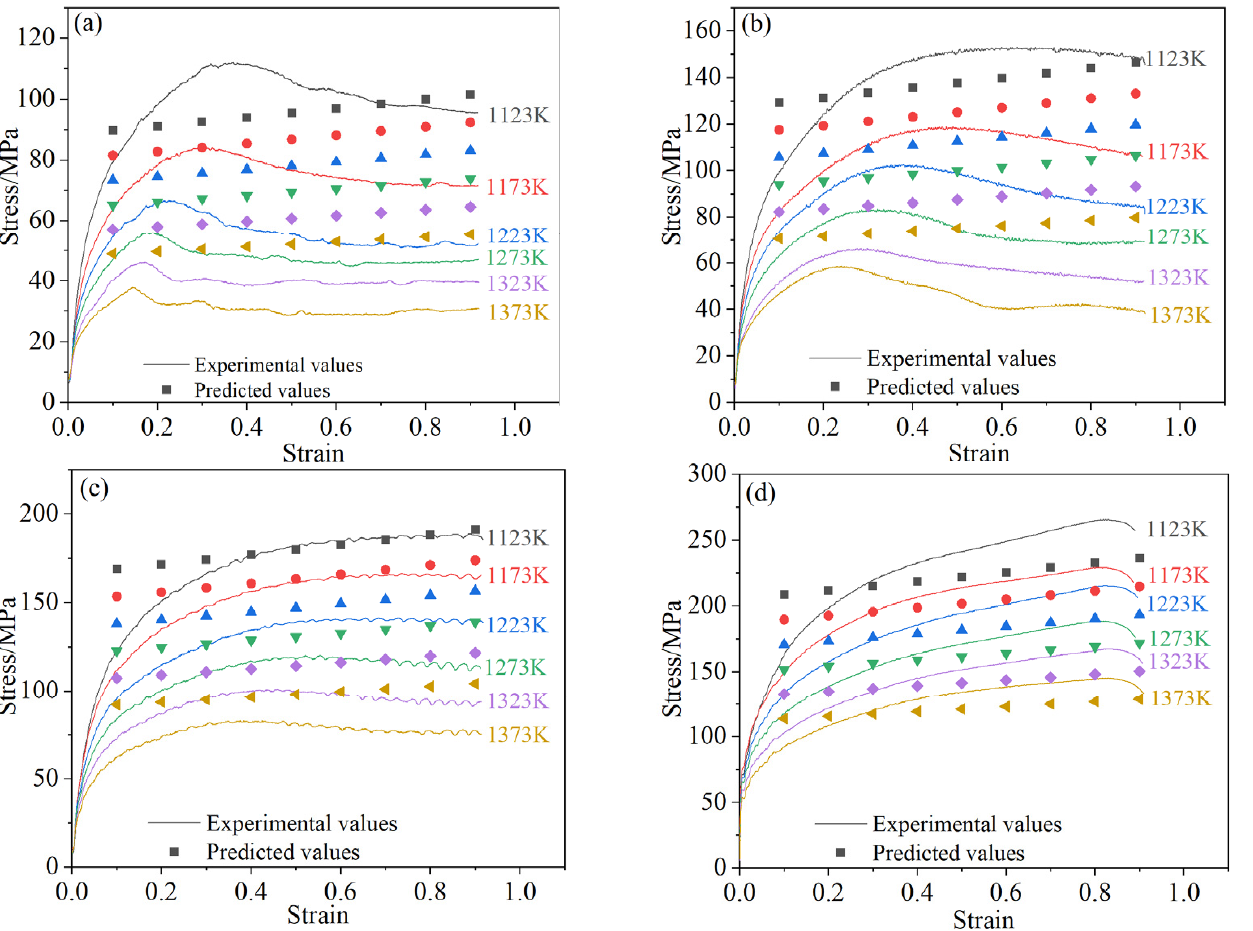
Figure 4. Comparison between predicted and experimental flow stress using Johnson–Cook model at different strain rates: ( a ) 0.01 s − 1 ; ( b ) 0.1 s − 1 ; ( c ) 1 s − 1 ; ( d ) 10 s − 1 . Table 3. Absolute error mean value and relative error mean value of three kinds of constitutive models under different deformation conditions.